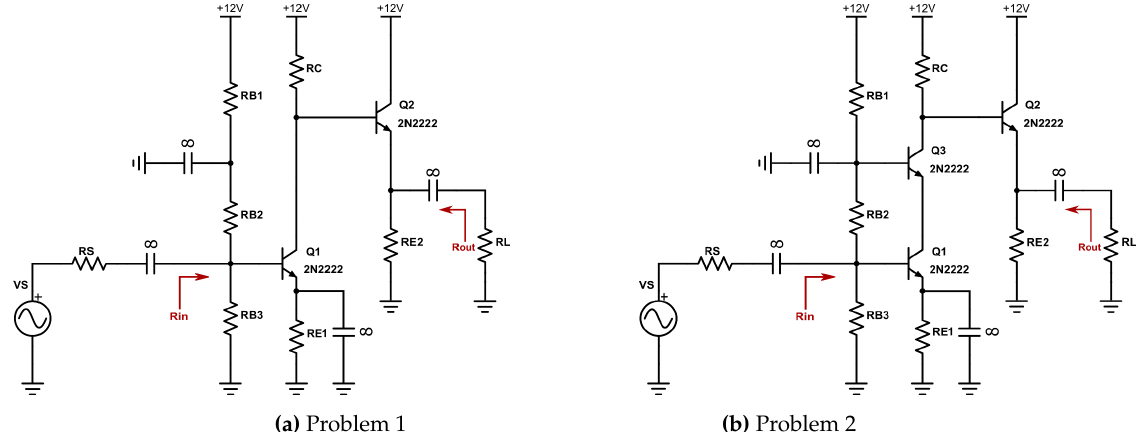
Figure 2. Schematics of the BJT amplification stages: ( a ): Problem 1. ( b ): Problem